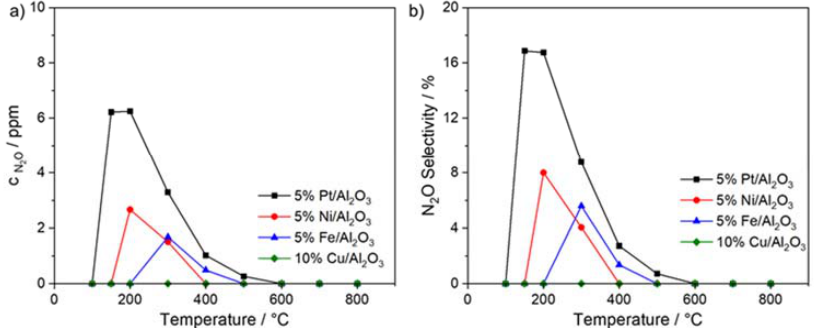
Figure 7. ( a ) N 2 O concentration and ( b ) N 2 O selectivity over reaction temperature for different transition metal catalysts, platinum-based catalyst shown for comparison, WHSV = 600 L/g h.